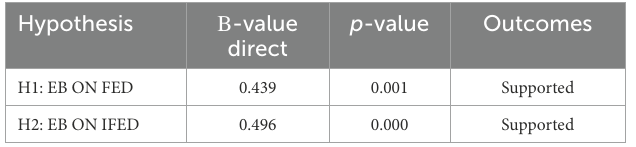
TABLE 5 Direct relationship.